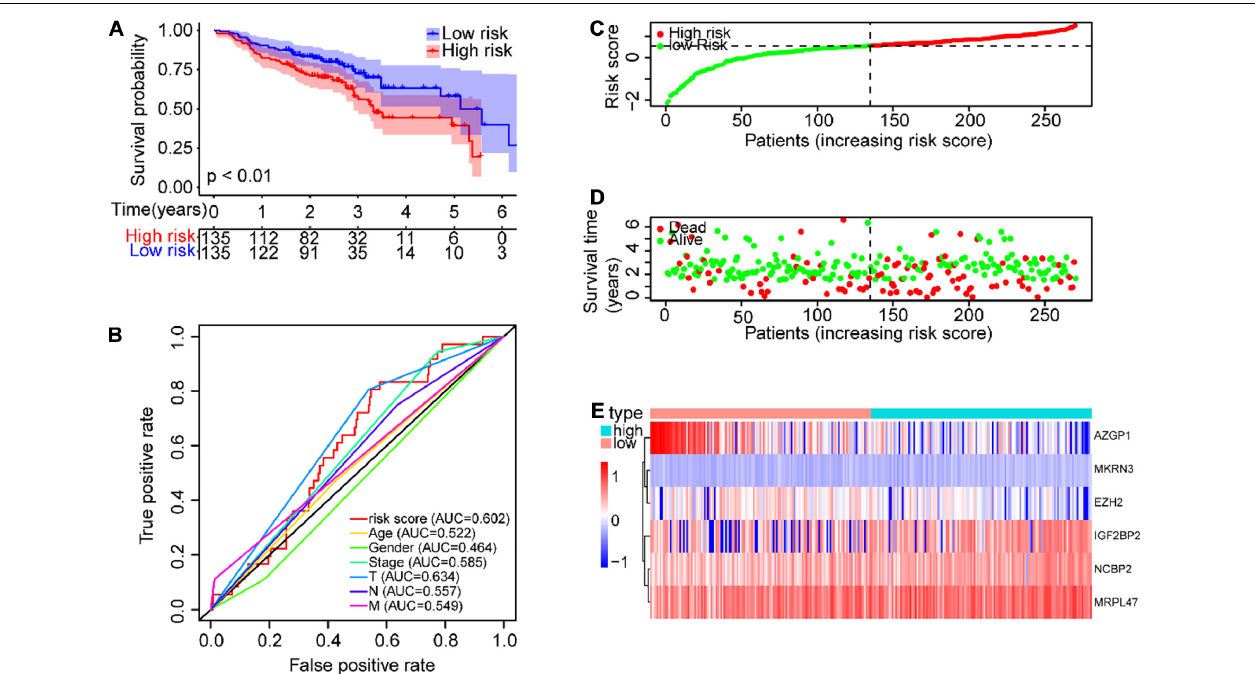
FIGURE 6 | Validation of the risk model in GEO (GSE65858) data set. (A) Kaplan–Meier survival curve with OS of SCCHN patients in the risk subgroups of the GSE65858 (GEO) data set. (B) ROC curve showing the AUC value of the risk score and other clinical factors of SCCHN patients in the GSE65858 data set. (C) The risk score distribution of SCCHN patients in the high-risk and low-risk groups. (D) Scatter plot showing the survival status of SCCHN patients. (E) The expression patterns of risk genes of SCCHN samples in the GSE65858 data set.